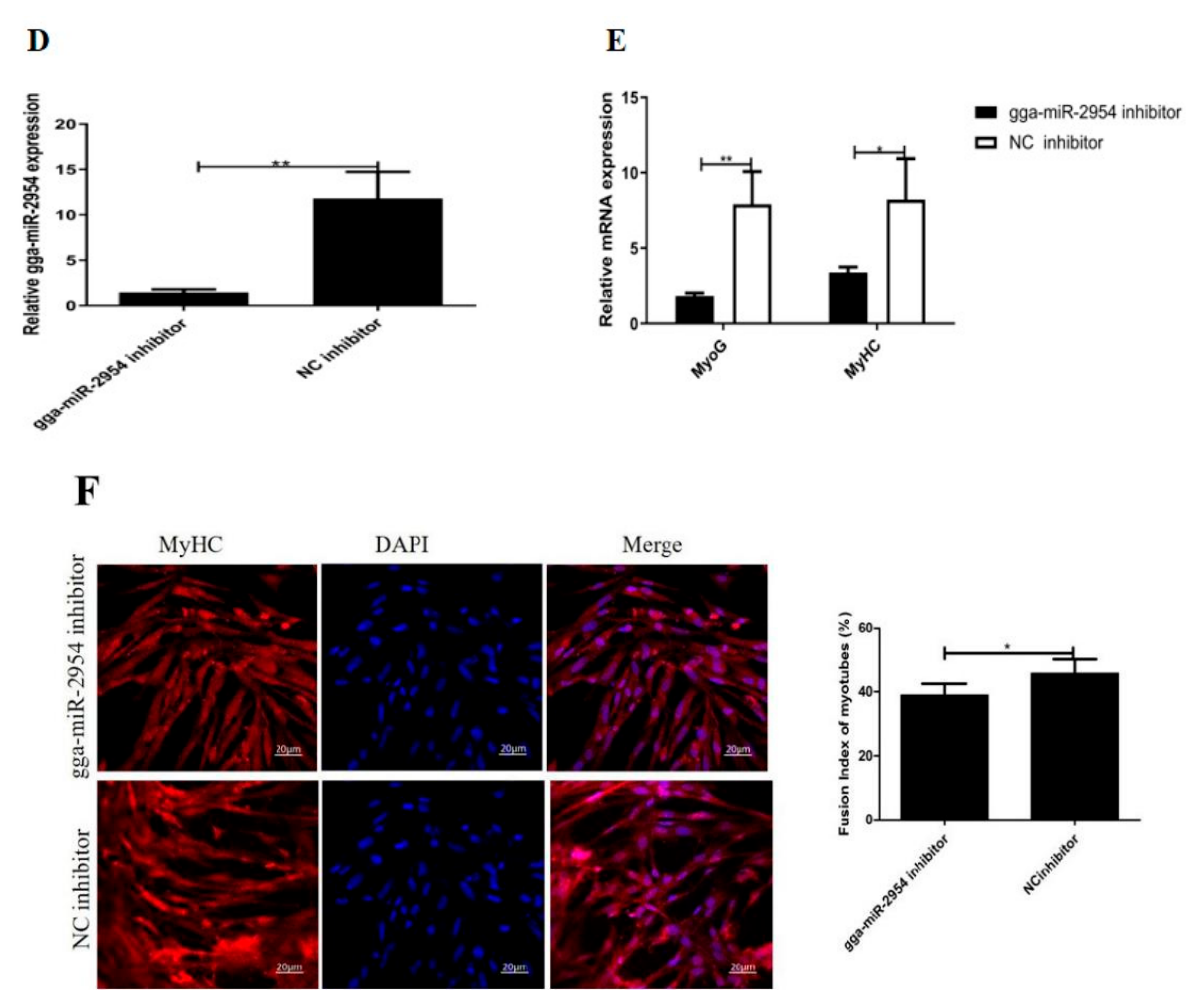
Figure 4. Gga ‐ miR ‐ 2954 promotes myogenic differentiation. ( A ) The expressive efficiency of gga ‐ miR ‐ 2954 mimics. ( B ) The mRNA expression of MyoG and MyHC after transfection with gga ‐ miR ‐ 2954 mimics or NC mimics. ( C ) The results of MyHC immunofluorescent staining after transfection with gga ‐ miR ‐ 2954 and NC mimics. Bar = 20 μ m. ( D ) The expression of gga ‐ miR ‐ 2954 after its inhibitor transfection. ( E ) The mRNA expression of MyoG and MyHC after gga ‐ miR ‐ 2954 inhibitor and NC transfection. ( F ) The results of MyHC immunofluorescent staining after gga ‐ miR ‐ 2954 inhibitor and NC transfection. All results were presented as the mean ± SEM from at least three independent experiments (* P < 0.05; ** P < 0.01).